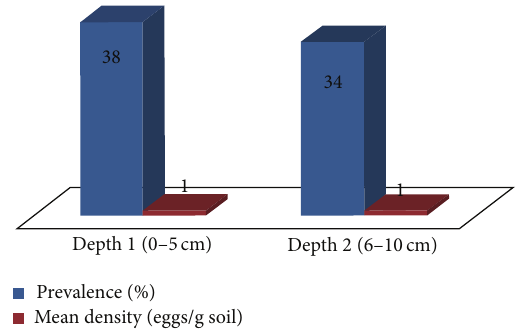
Figure 4: Prevalence and mean density of Toxocara eggs at different depths in soils from selected towns in Laguna,